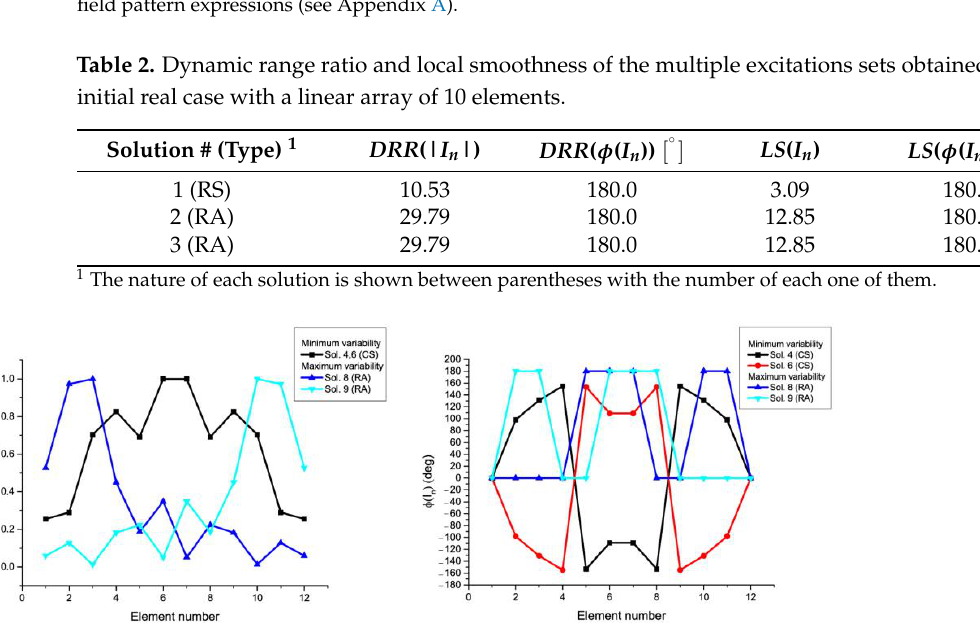
Figure 5. Magnitudes ( left ) and phases ( right ) of the current excitations with maximum and minimum variability linked to the solutions of the synthesis in the RPC of 12-element linear array (see the pattern in Figure 2). The numbering of the solution agrees with Figure 1. Solutions 4 and 6 are mirror images of each other and because they are symmetric, they refer the same values in amplitude.